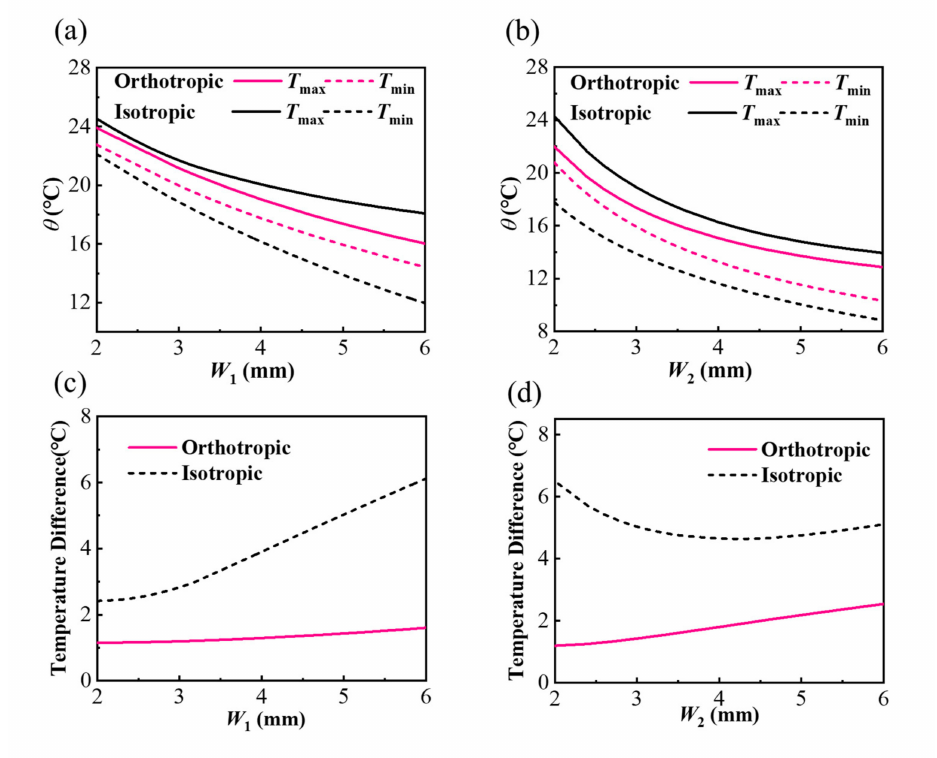
Figure 6. ( a , b ) The maximum ( T max ), the minimum ( T min ) temperature and ( c , d ) temperature difference on the bottom surface of the orthotropic and isotropic model with different vertical space W 1 and horizontal space W 2